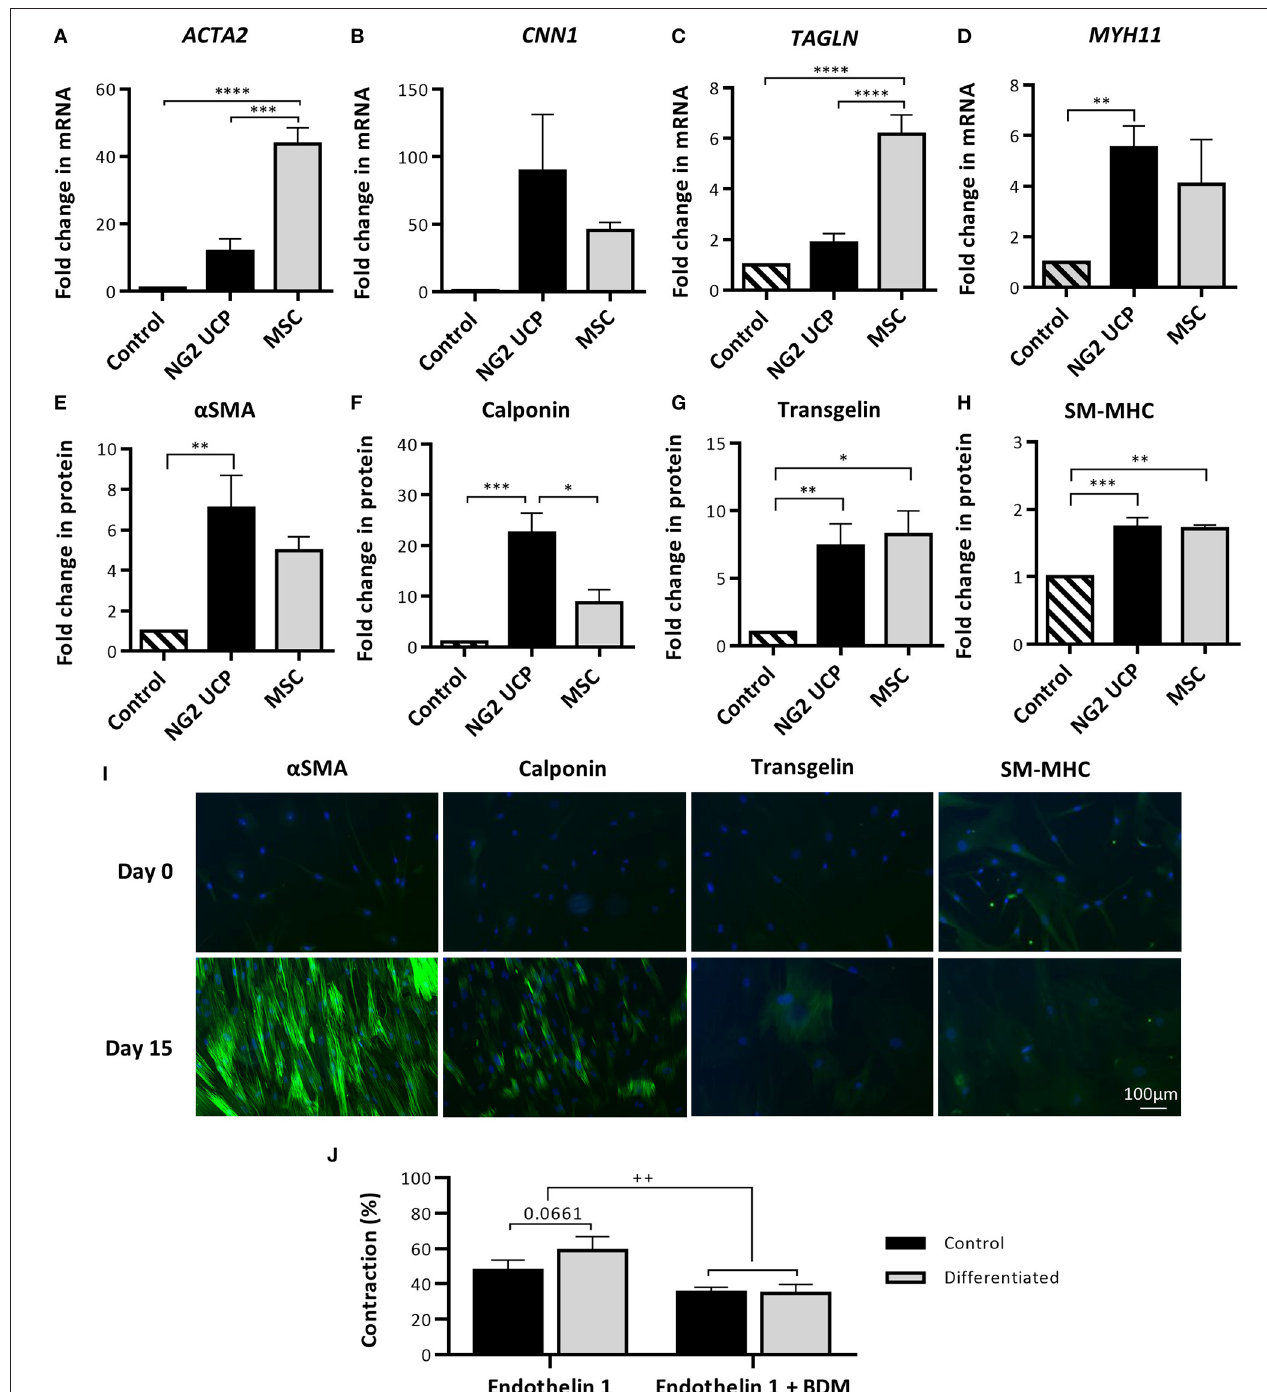
FIGURE 4 | Analysis of NG2 UCP capacity to differentiate toward a contractile vascular smooth muscle-like phenotype. (A–D) Fold change in mRNA levels of VSMC markers after differentiation vs. undifferentiated (control). ACTA2 , α SMA; CNN1 , Calponin; TAGLN , Transgelin; MYH11 , SM-MHC. (E–H) Fold change in protein levels of VSMC markers after differentiation protocol. For (A–H) , data represent means ( ± S.E.M). MSCs and NG2 UCPs, n = 3 and 5 biological replicates, respectively; * p < 0.05; ** p < 0.01; *** p < 0.001; **** p < 0.0001. (I) Immunocytochemical staining of VSMC markers at day 0 (undifferentiated) and day 15 (differentiated). (J) Gel contraction in differentiated and undifferentiated NG2 UCPs after activation with endothelin-1 in the presence or absence of BDM. Data represent means ( ± S.E.M) of n = 5 biological replicates. ++ p < 0.01.